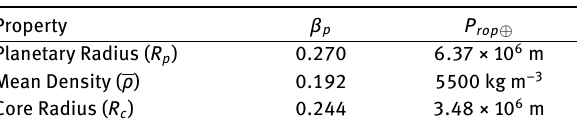
Table 1. Scaled properties exponent for massive terrestrial planets and its values for the Earth